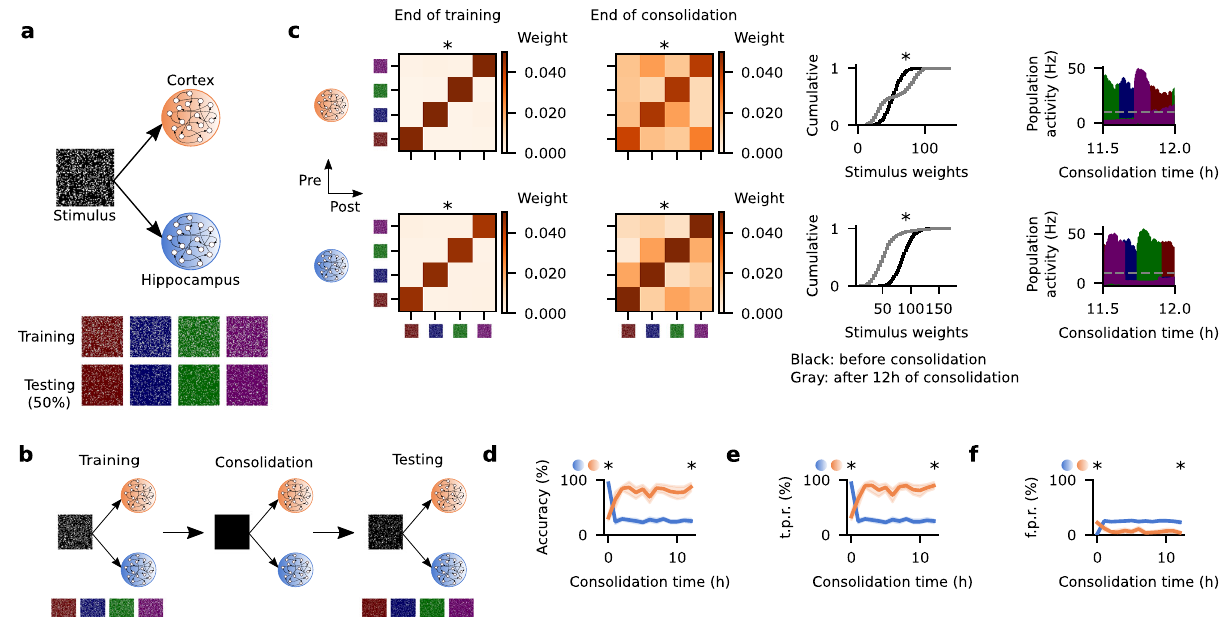
Fig. 1 Divergent synaptic plasticity timescales lead to opposite engram cell dynamics. a Schematic of network model with Stimulus (STIM), Hippocampus (HPC), and Cortex (CTX) (top) and stimuli presented in the training phase with their respective partial cues used in the testing phase (bottom). In STIM, training stimuli, and testing stimuli, light gray indicates active neurons fi ring above baseline whereas the remaining background color (i.e., black in STIM and red/blue/green/purple in training and testing stimuli) indicates neurons at baseline fi ring rate. Each background color in training and testing stimuli denotes a distinct non-overlapping stimulus and its respective partial cue. b Schematic of simulation protocol. c From left to right: mean weight strength of recurrent excitatory synapses onto excitatory neurons at the end of the training phase clustered according to engram cell preference (i.e., only mean weights between engram cells), mean weight strength of recurrent excitatory synapses onto excitatory neurons after 12 h of consolidation clustered according to engram cell preference (i.e., only mean weights between engram cells), cumulative distribution of the total feedforward synaptic weights from STIM onto individual engram cells, and population activity of engram cells in the consolidation phase (each color designates the engram cells encoding the respective stimulus in ( a ); dashed line indicates threshold ζ thr = 10 Hz for engram cell activation). Top: CTX. Bottom: HPC.